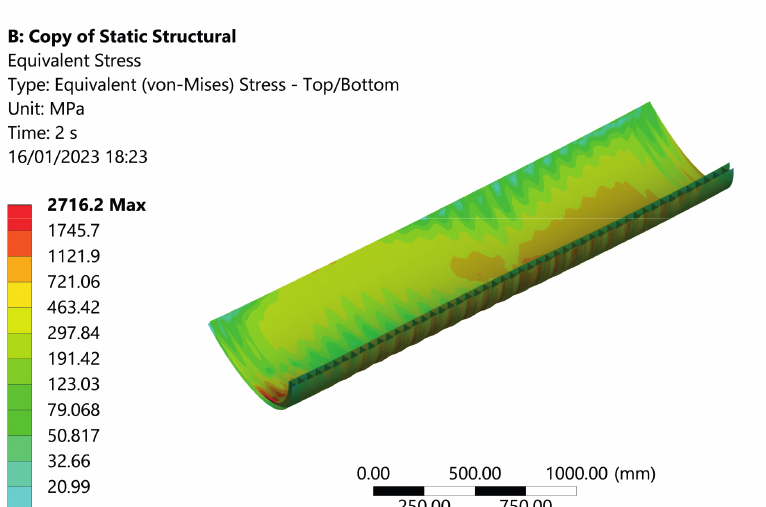
Figure 18. Von Mises stress [MPa] for the corrugated core ITPS subjected to coupled pressure and thermal